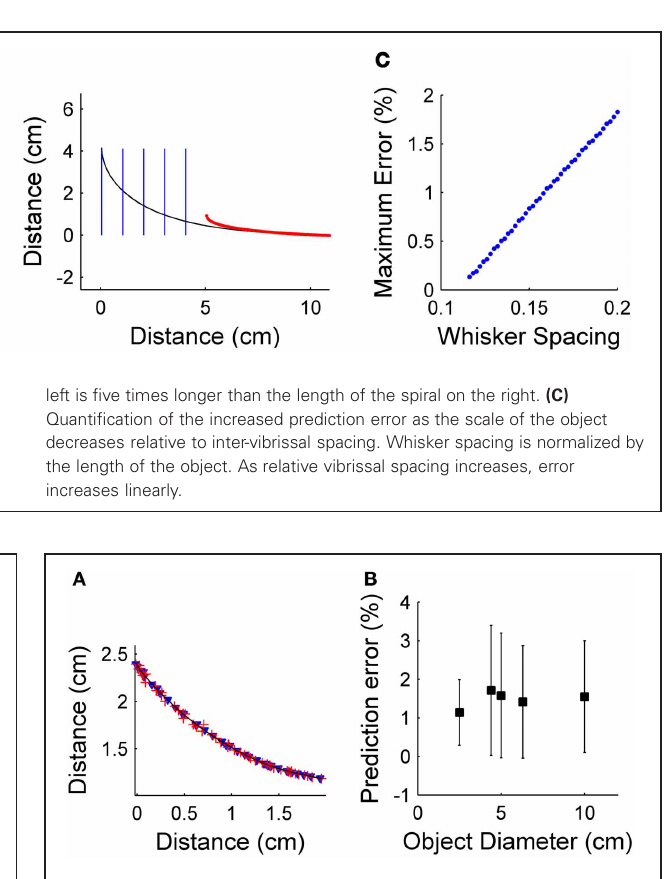
FIGURE 9 | (A) Predicted radial distance plotted over a solid line indicating the actual profile of the cylinder. Predicted radial distances use local object curvature (blue) or local object slope (red). (B) Prediction error as the object diameter increases. There is no statistical difference between errors ( p > 0 .